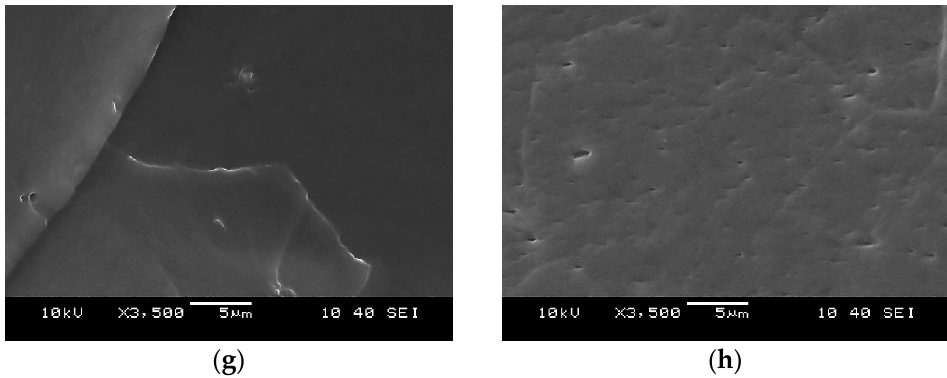
Figure13. SEMimagesofthecryo-fractured,andcryo-fracturedandetchedsurfacesof( a , b )TPU125 / NBR, ( c , d ) TPU125 / XNBR, ( e , f ) TPU125 / ENR, and ( g , h ) neat Figure 13. SEM images of the cryo-fractured, and cryo-fractured and etched surfaces of ( a , b ) TPU125/NBR, ( c , d ) TPU125/XNBR, ( e , f ) TPU125/ENR, and ( g , h ) neat TPU125.